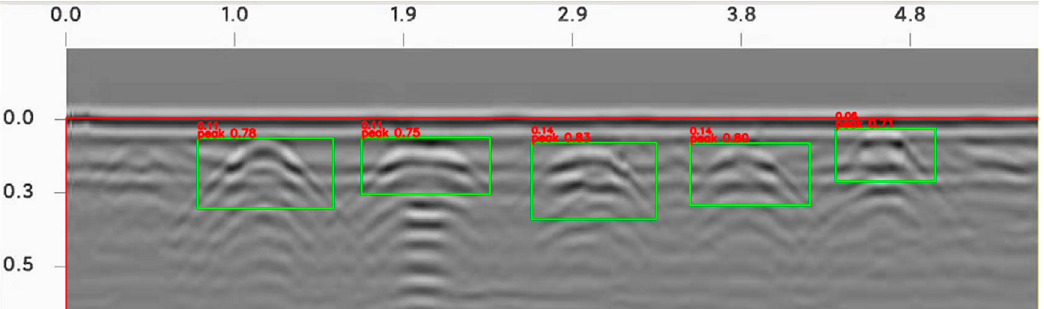
Figure 21. Target location results of ground penetrating radar image 1.